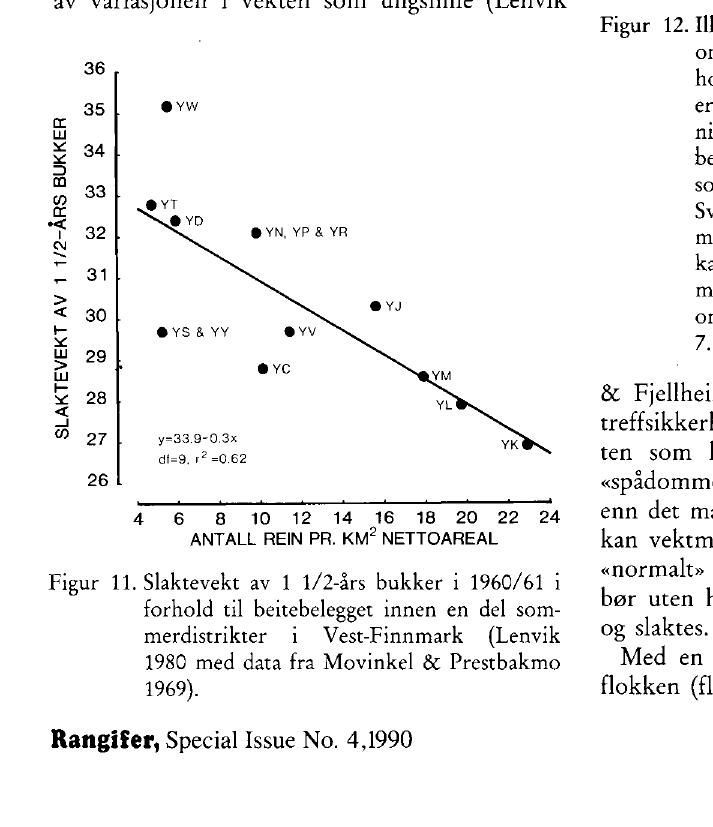
Figur 11. Slaktevekt av 1 1/2-års bukker i 1960/61 i forhold til beitebelegget innen en del som-